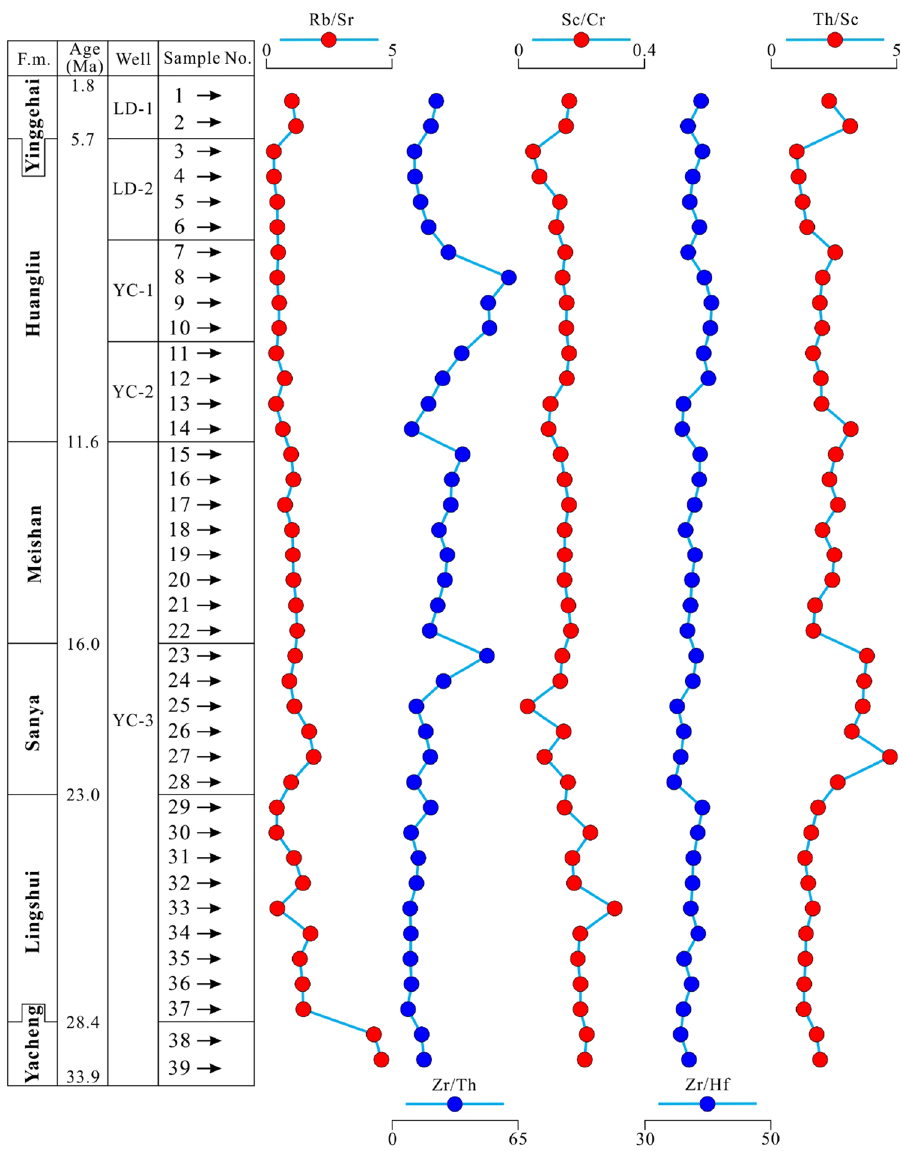
Figure 5. Comparative variations in the trace elemental ratios from Wells in the junction area of Yinggehai and Qiongdongnan basins,